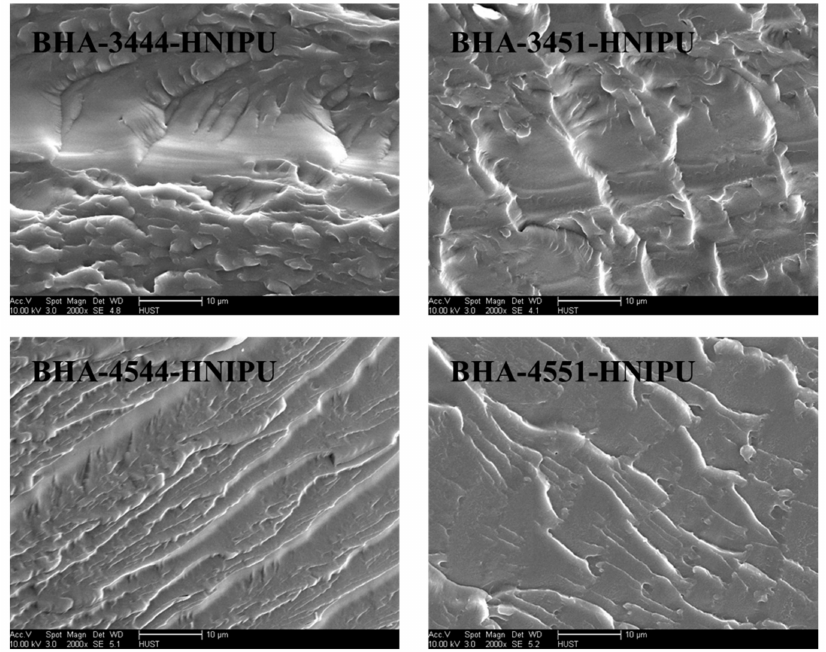
Figure 12. SEM images of HNIPUs.